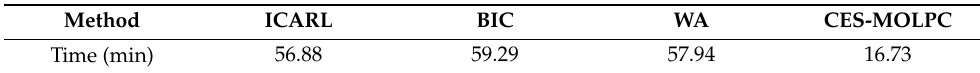
Table 8. Algorithm running time comparison on ACARS data set ( T =